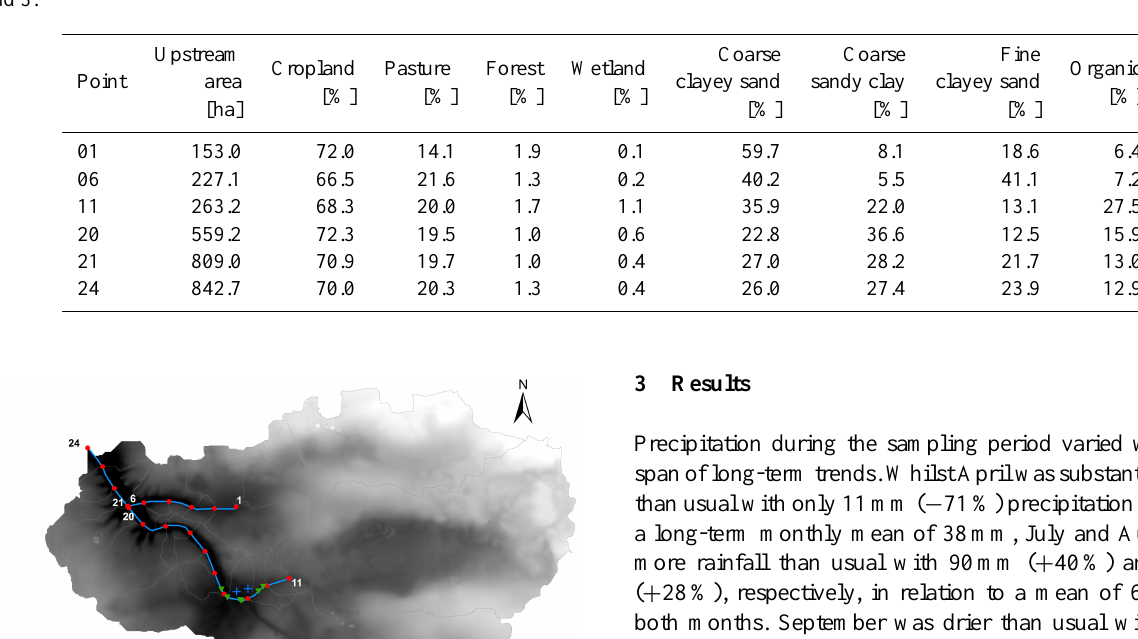
Table 1. Upstream area with related land use and soil type in the top layer calculated with ArcGIS. Point numbers correspond to Figs. 1, 2 and 3.